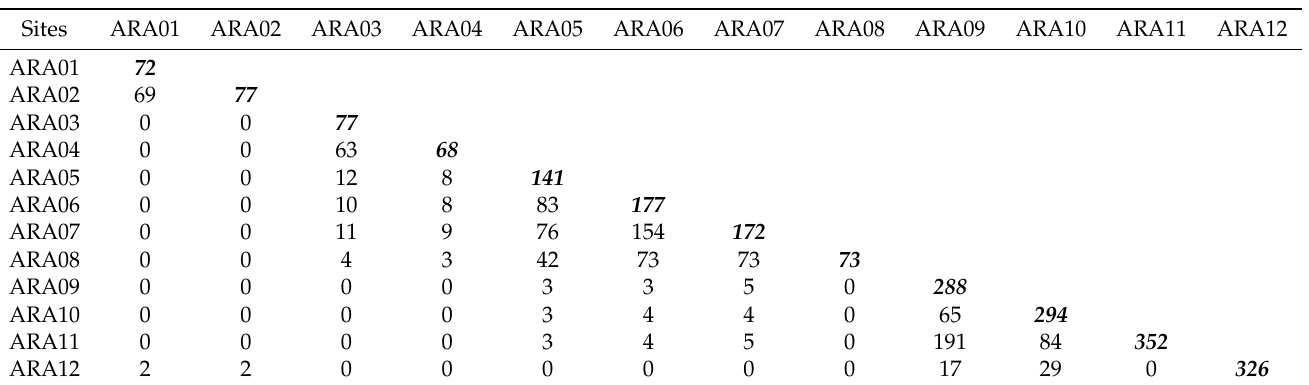
Table A1. Total number of clones tested within sites in the Arauco zone. On the diagonal is the total number of clones within each site, and on the off-diagonals is the number of common clones tested in pairs of sites.